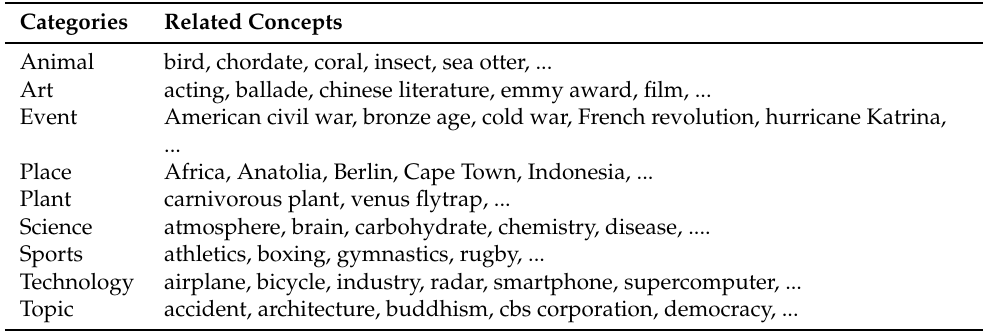
Table 1. The overview of golden